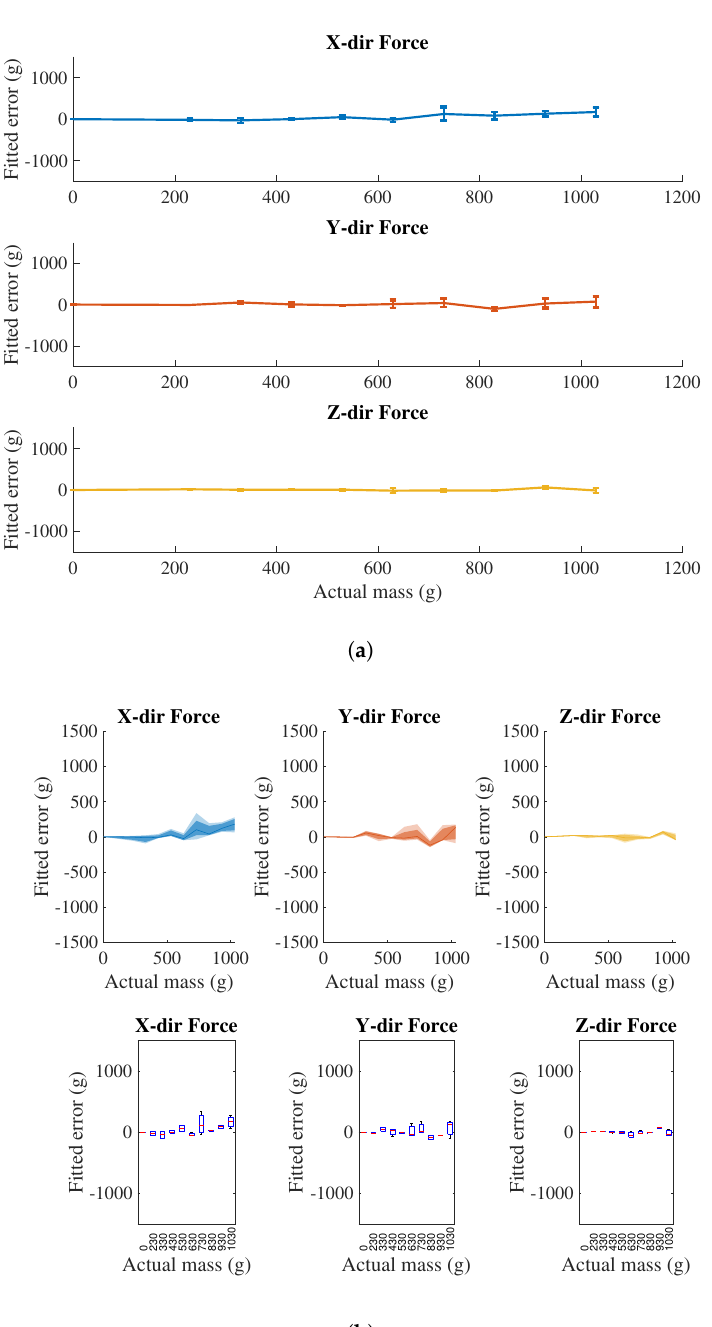
Figure A6. Central measures and spread of component-wise residuals as a function of the overall actual load applied. For this sensor, each load has 3–4 associated configurations each with a residual error. ( a ) Means of multiple residuals tied to each overall load are represented by the centerline, while standard deviation is represented by error bars, extending above and below by 1 s.d. ( b ) Medians of residuals tied to each overall load are represented as a centerline in the envelope plot, 25-percent and 75-percent quartiles are represented by a darker region, and upper/lower extremes are represented by lighter